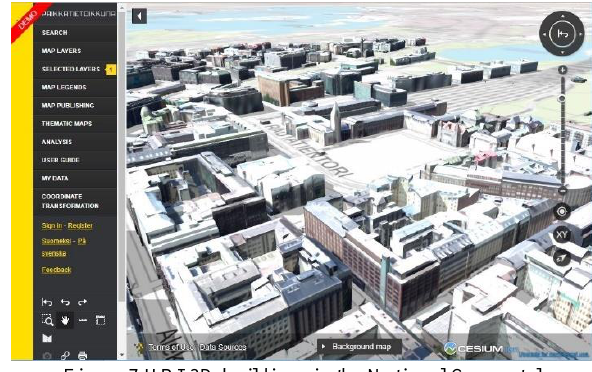
Figure 7 HRI 3D buildings in the National Geoportal Cesium ion supports also point cloud data. Kuopio city point cloud data was imported to Cesium ion and visualized in the National Geoportal by configuring the size and colors of the points.